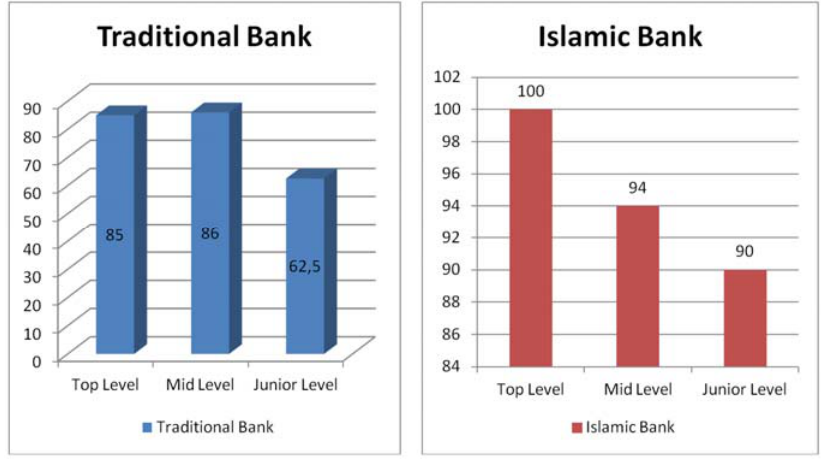
Fig. 2. CSR concept and understanding of different level of management